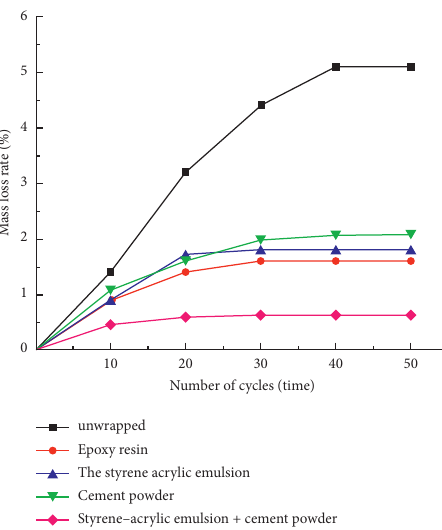
Figure 13: Mass loss rate of phase change expanded perlite under different encapsulation